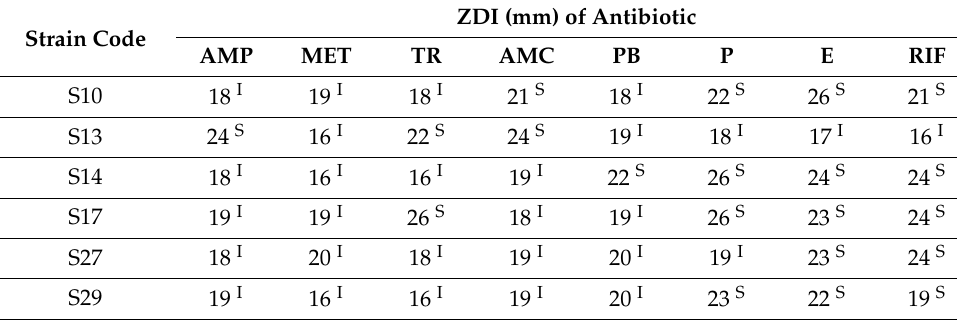
Table 2. Antibiotic susceptibilities of six isolated LAB